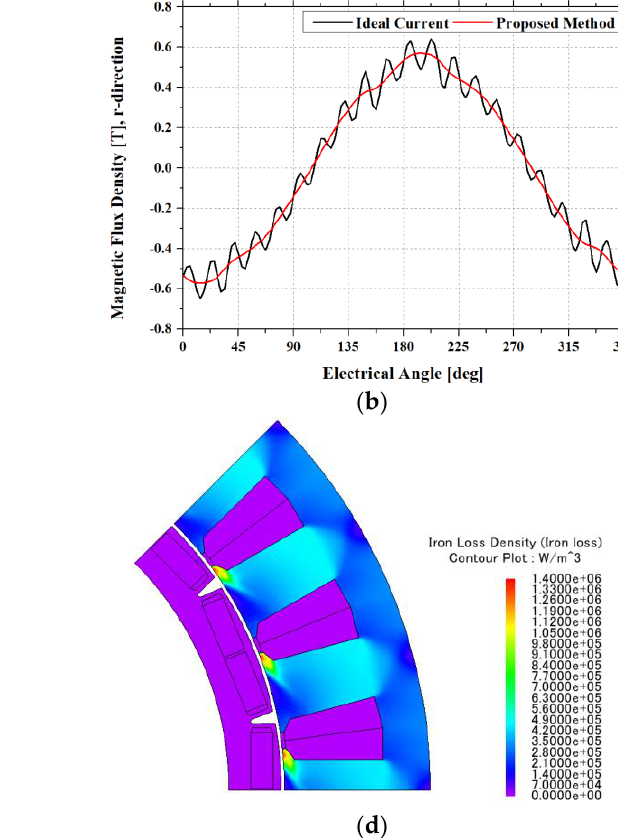
Figure 6. Comparison of magnetic flux and iron loss densities. ( a ) Magnetic flux density of in the stator core: θ -direction; ( b ) Magnetic flux density in the stator core: r-direction; ( c ) Iron loss density at 8000 Hz (ideal current source); (d) Iron loss density at 8000 Hz (proposed method).